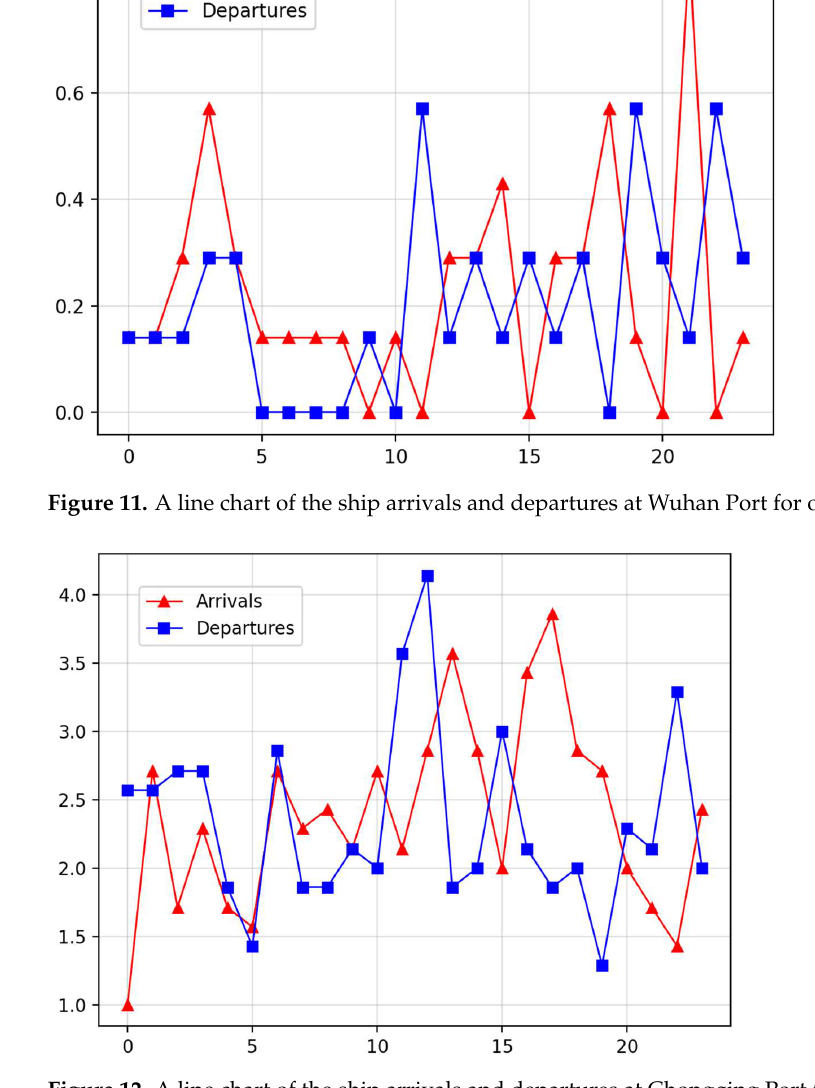
Figure 12. A line chart of the ship arrivals and departures at Chongqing Port for one day. Generally speaking, the arrival and departure of ships were roughly equal at the same time point; the highest was from 10:00 AM to 16:00 PM, and the lowest was from